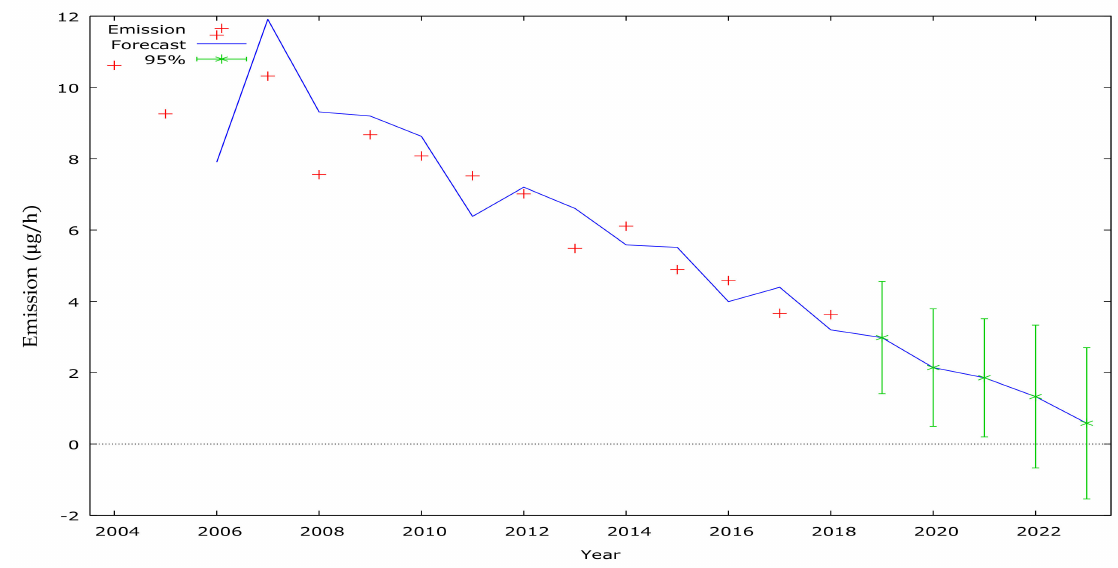
Figure 7. Graph of the dependence of the average SO 2 emission in µ g/h in individual years on the values forecasted using the ARIMA model (2,2,1), (averaging time 1 h, average value), zone code PL1401. Source: Own elaboration, based on data from Chief Inspectorate of Environmental Protection